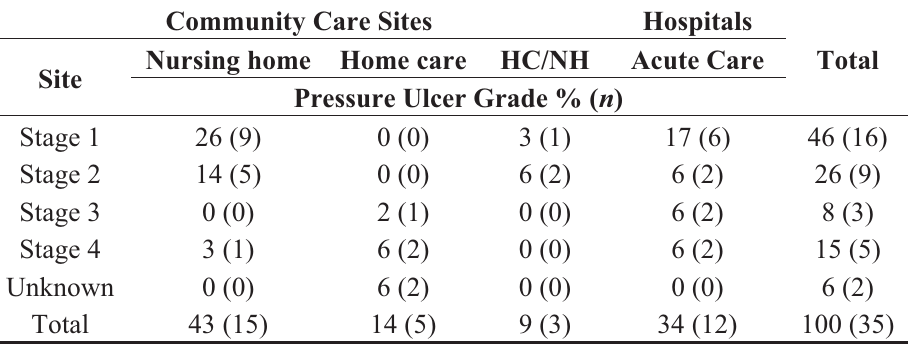
Table 2. Most severe pressure categories by care sites.